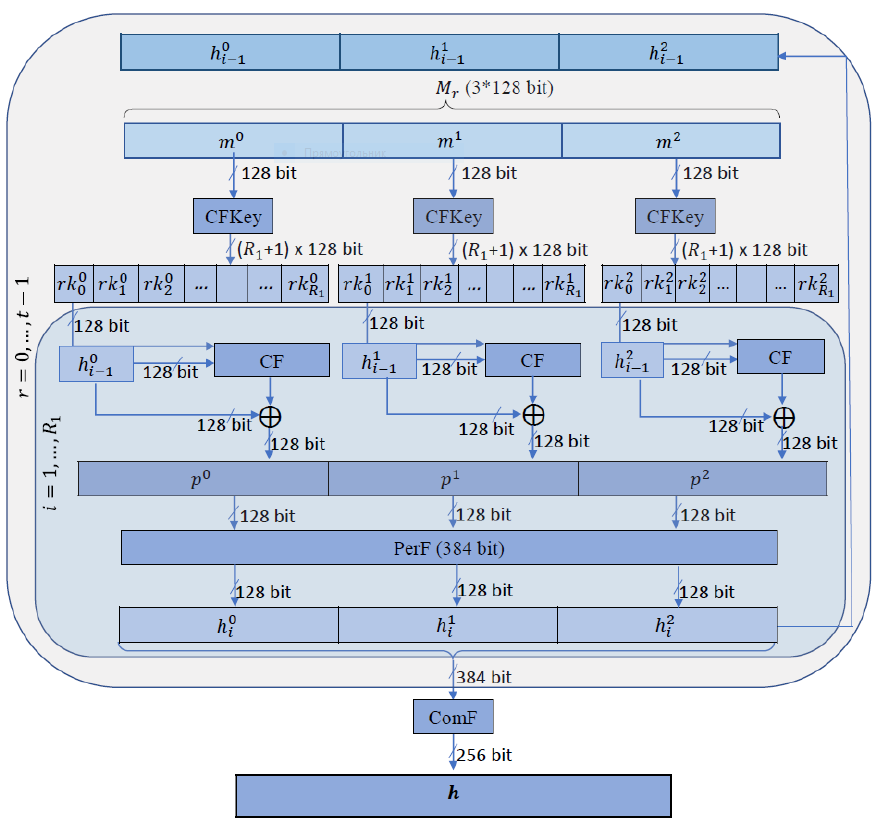
Figure 1. The general hashing scheme of the HBC-256 algorithm.